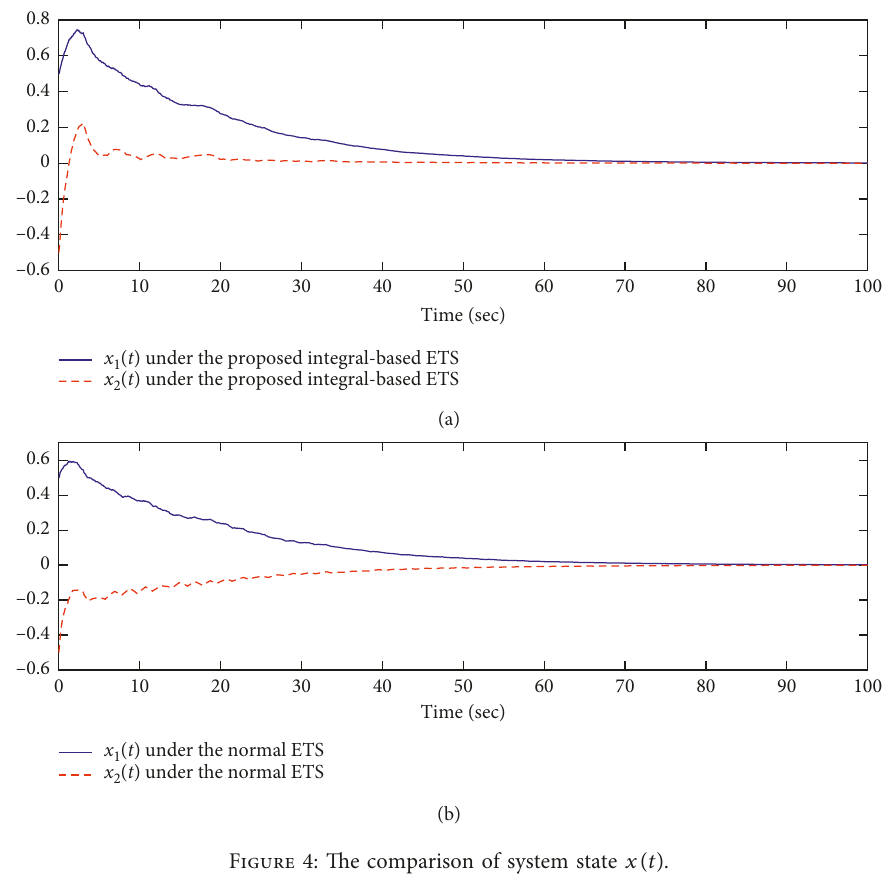
Figure 4: The comparison of system state x ( t ) .